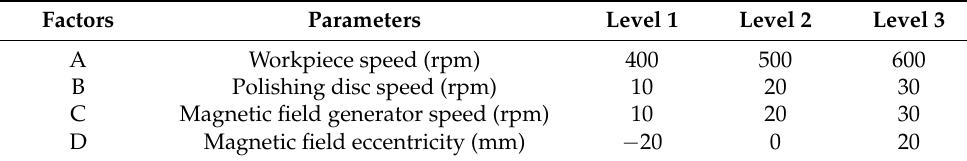
Table 2. Orthogonal experimental factors and level parameters.